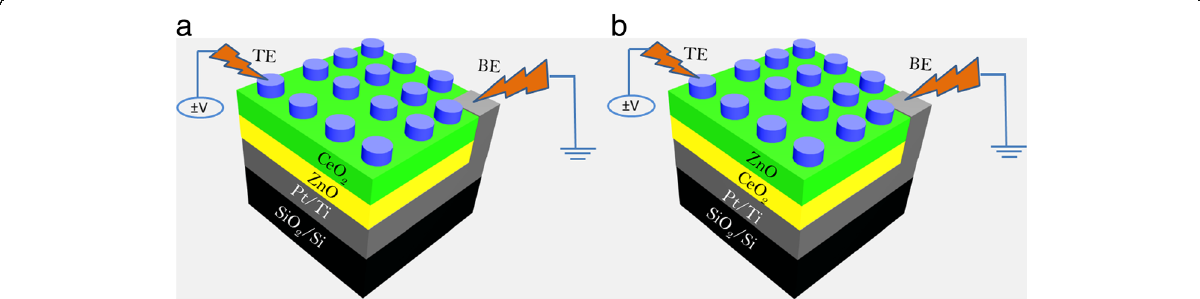
Fig. 1 Schematic configuration of the bilayer a Ti/CeO 2 /ZnO/Pt and b Ti/ZnO/CeO 2 /Pt devices